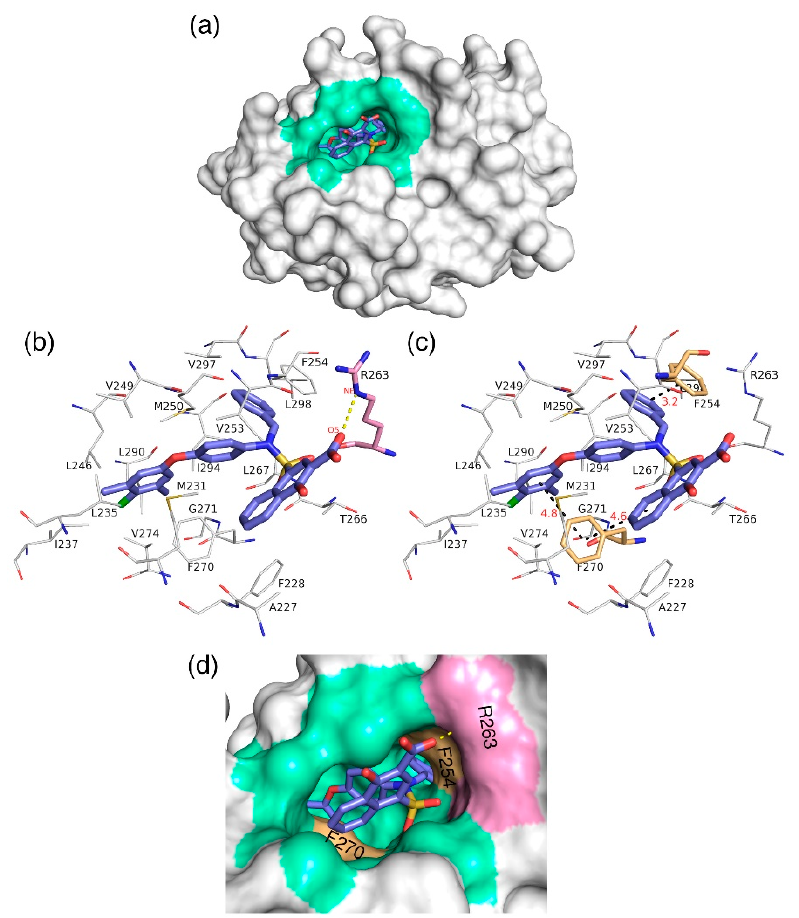
Figure 7. ( a ) Molecular surface representation to show the region where the highly active inhibitor— C40 —interacts with Mcl1. ( b ) The salt bridge (yellow dotted lines) ( c ) and π – π interactions (black dotted lines with distances in Å) between the highly active compound— C40 —and binding site residues of Mcl1. ( d ) A magnified view of the binding groove of Mcl1 (represented in surface) highlighting the principal interactions between the C40 and surrounding contacts.